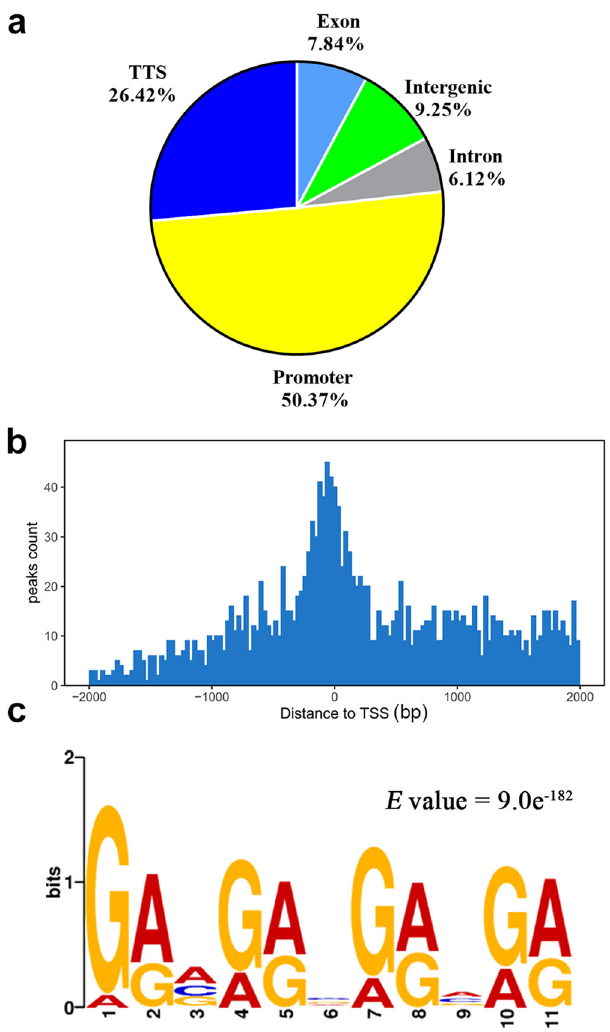
Fig. 2 Genome-wide identi fi cation of SREBP binding sites and motifs. a Relative binding-peak distribution across genomic regions. b Distance to the transcription start site (TSS) from SREBP binding sites. c The 2271 peak regions were analyzed for overrepresented motifs using MEME. The top- scoring motif is shown. The other preferred motifs are shown in Supplementary Fig.